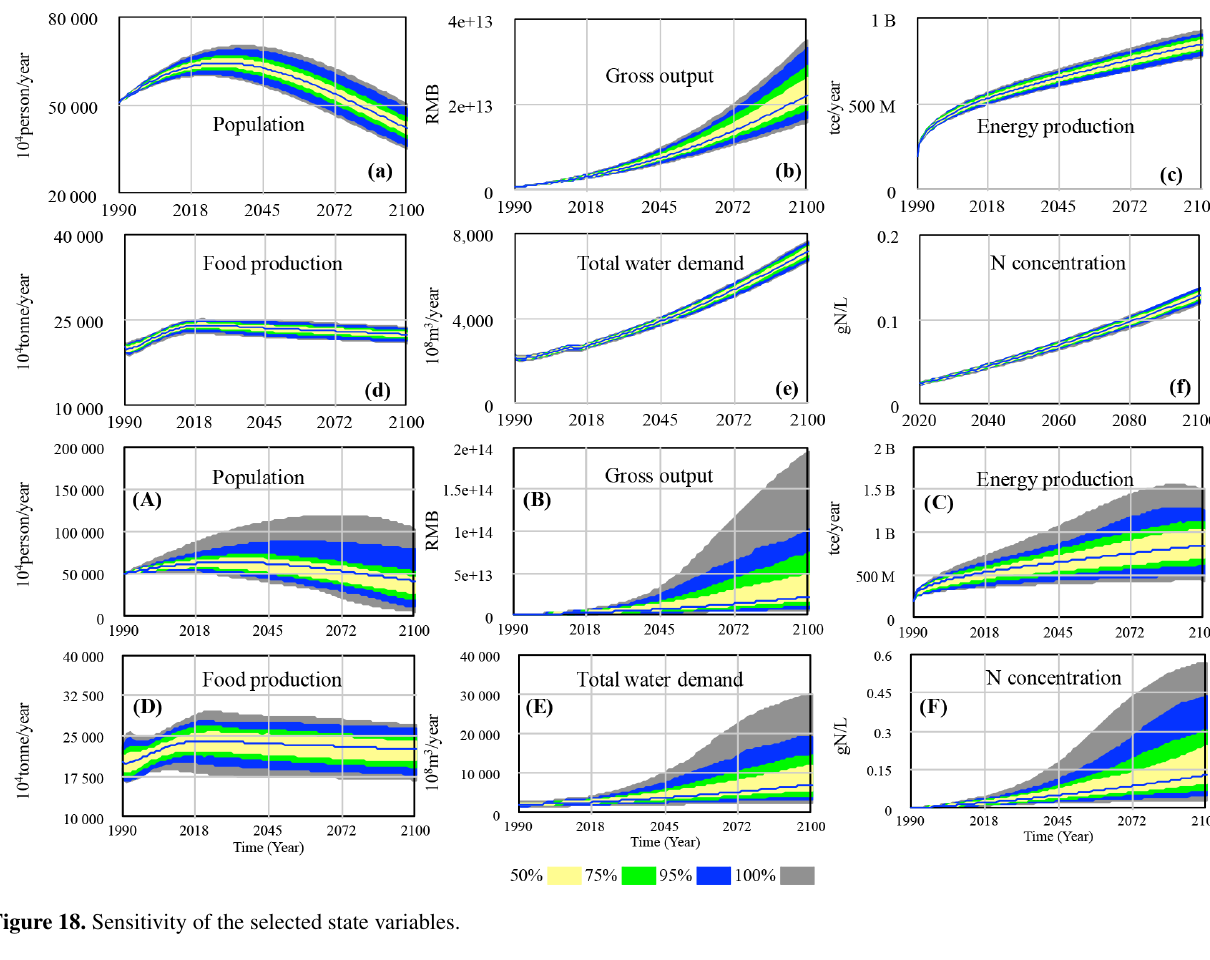
Figure 18. Sensitivity of the selected state variables.